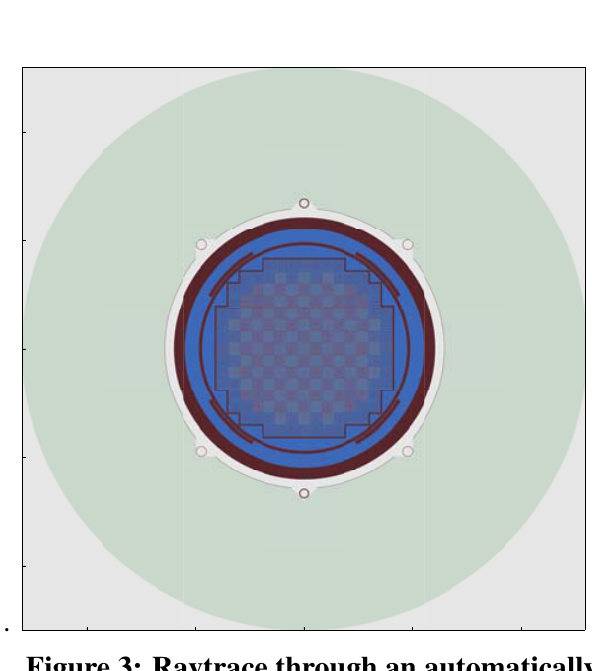
Figure 3: Raytrace through an automatically generated ex-core geometry for WBN1.